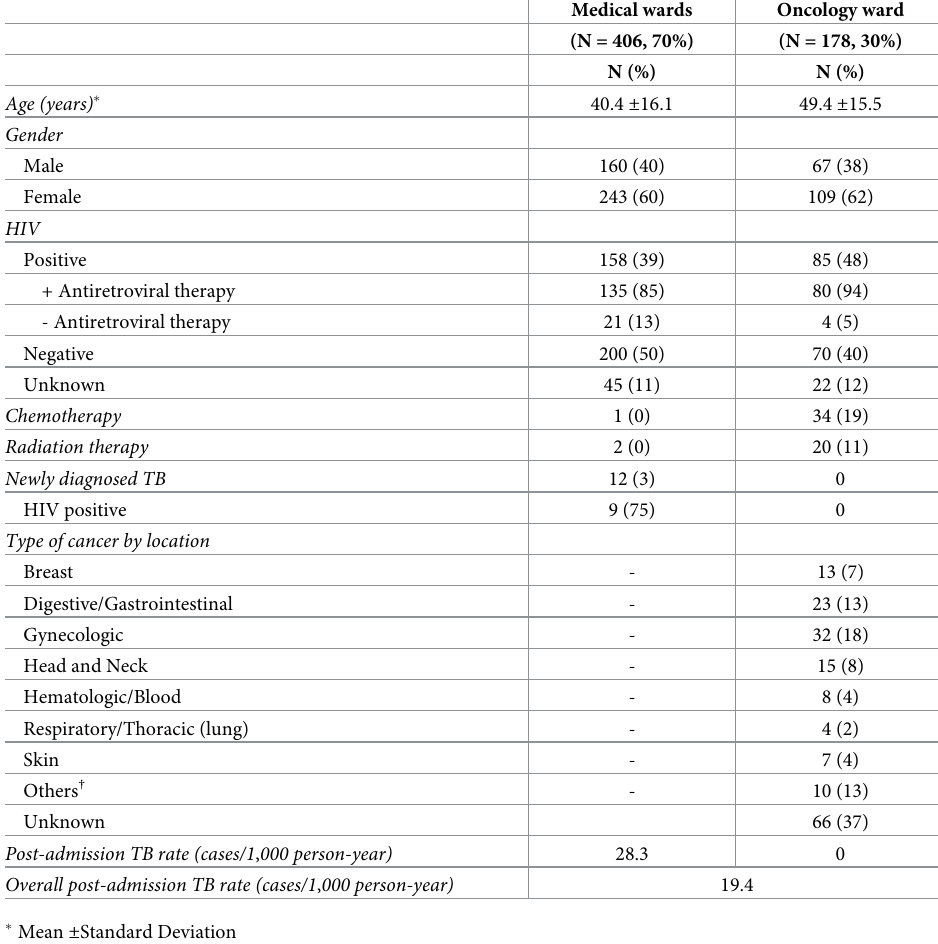
Table 2. Characteristics of follow-up cohort who were non-presumptive tuberculosis on enrollment (N = 584). Medical wards Oncology